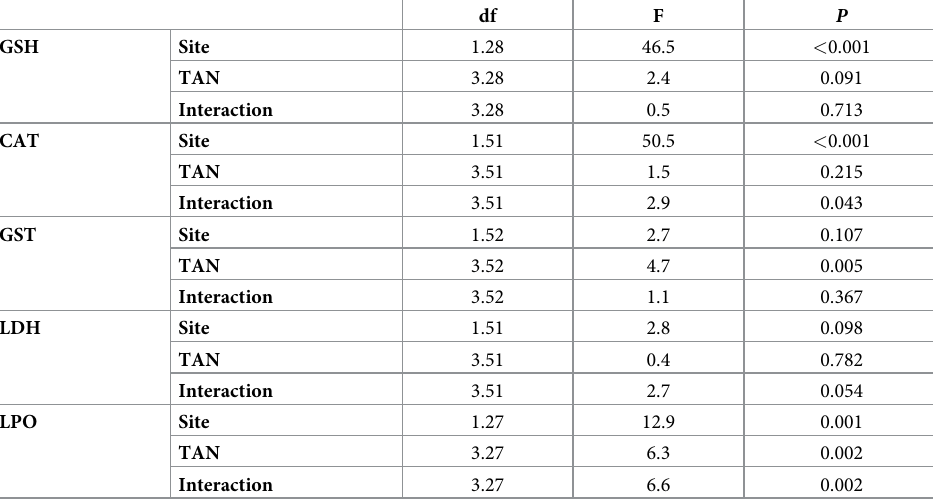
Table 2. Linear model results for testing the effects of site and TAN on the studied biomarkers in B . meridionalis .